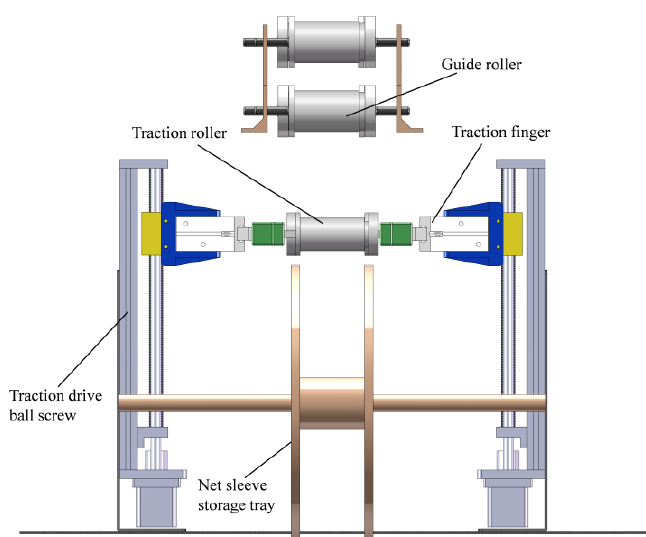
Figure 20. Schematic diagram of traction conveying mechanism.